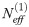
EWS for γ = 3.An increase in standard deviation as well as autocorrelation can be observed prior to the critical transition, both for the natural state N(1) (blue) and the effective state Neff(1) (green) in networks with γ = 3. Note that the effective state shows a much clearer signal with less fluctuations than the natural state.